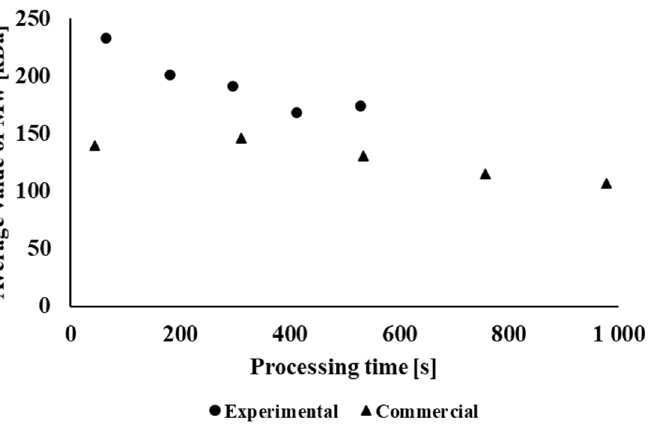
Figure 5. Molar mass distribution of individual processing cycles of experimental and industrial types of the NONOILEN ® 3D 3056-2 material.